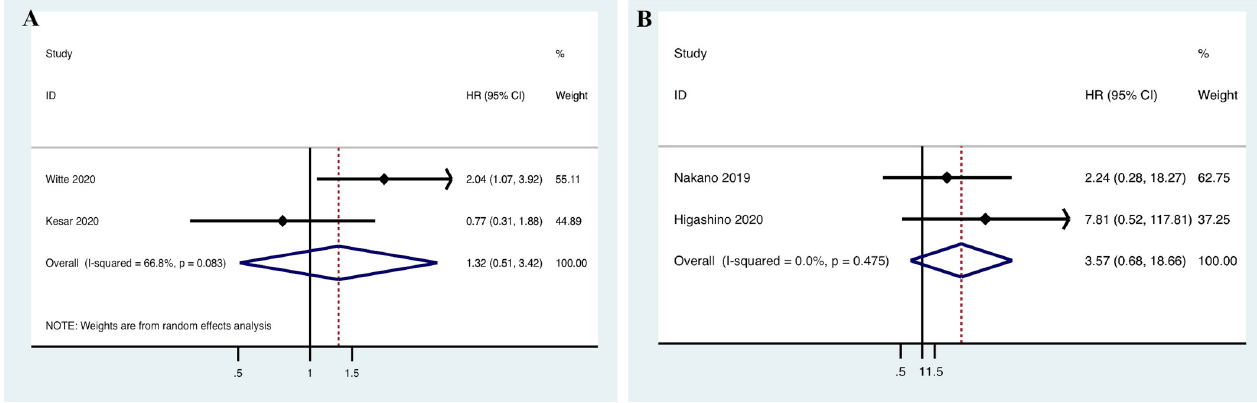
Fig 5. Forest plot for the association between programmed cell death ligand 1 (PD-L1) expression and (A) the progression-free survival (PFS); and (B) the disease-specific survival (DSS) of salivary gland carcinoma (SGC) patients. HR, hazard ratio; CI: confidence interval.